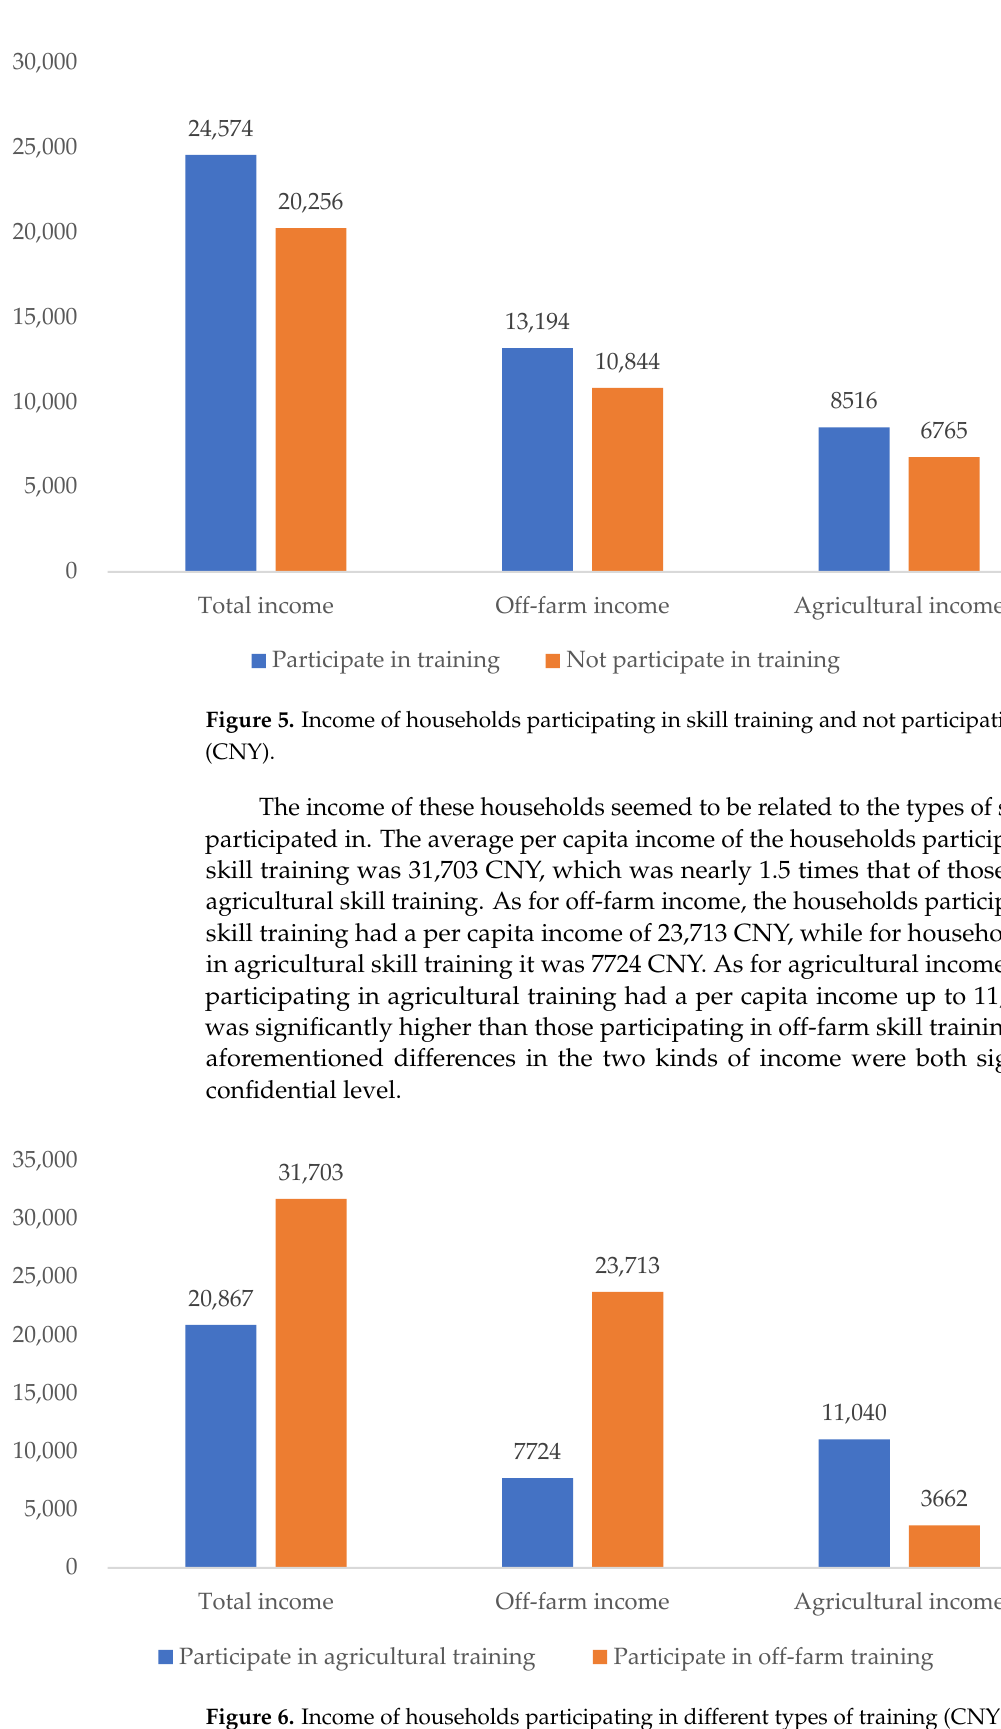
Figure 6. Income of households participating in different types of training (CNY).